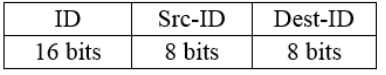
Figure 3. The structure of the Figure 4. The structure of